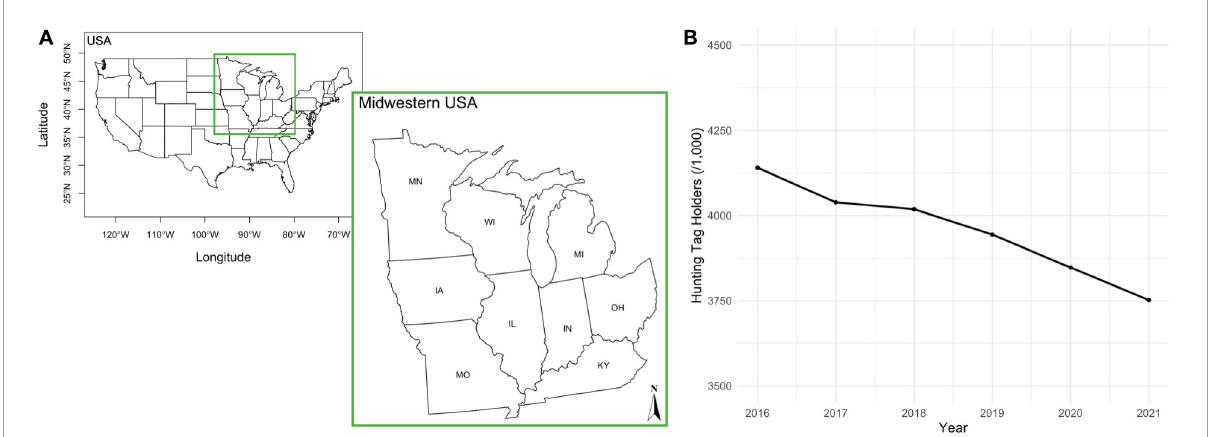
FIGURE3 (A) An inset map of nine Midwestern states of interest: Iowa (IA), Illinois (IL), Indiana (IN), Kentucky (KY), Michigan (MI), Minnesota (MN), Missouri (MO), Ohio (OH), and Wisconsin (WI). (B) The number of hunting license holders across the nine states in panel (A) from 2016 to 2021 [y-axis range: 3.5–4.5 million, data from USFWS